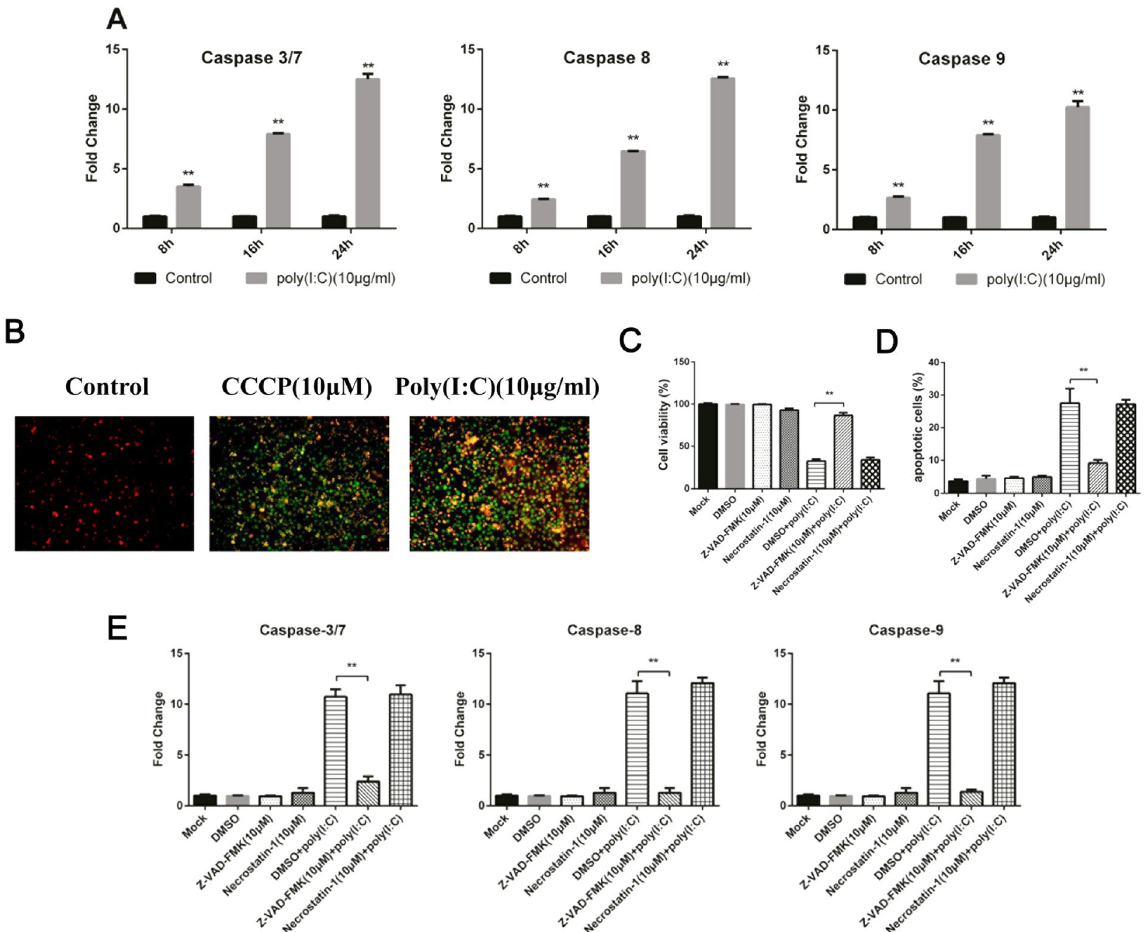
Figure 2. The activation of caspase pathway in MDCC-MSB1 cells cultured with poly (I:C). ( A ) The activities of caspases 3/7, 8, and 9 were measured in MDCC-MSB1 cells cultured with poly (I:C) (10 μ g/ml) for 8, 16 and 24 h.The relative activity of the caspases was calculated as in Materials and Methods. ( B ) MDCC-MSB1 cells were cultured for 24 h with or without poly (I:C) (10 μ g/ml), then stained with 5 μ M JC-1 dye for 10 min at 37 °C to evaluate mitochondrial membrane potential integrity. Mitochondria with normal membrane potentialare shown in red, and mitochondria experiencing a loss of membrane potential are indicated in green. ( C ) MDCC- MSB1 cells were pre-treated with pan-caspase inhibitor Z-VAD-FMK, Necrostatin-1 or DMSO (used as control) before culture with or without poly (I:C) (10 μ g/ml) for 24 hours. The percentage of cell viability is shown. ( D ) MDCC-MSB1 cells were pre-treated with the pan-caspase inhibitor Z-VAD-FMK, Necrostatin-1 or DMSO (used as control) before culture with or without poly (I:C) (10 μ g/ml) for 24 hours. Results are expressed as a percentage of the apoptotic cells. ( E ) The caspase activity of MDCC-MSB1 cells, obtained as described in ( A ), was measured. The asterisk ( * ) or double asterisk ( ** ) respectively indicates p < 0.05 or p < 0.01 in statistical difference from controls. The bars represent an average of multiple